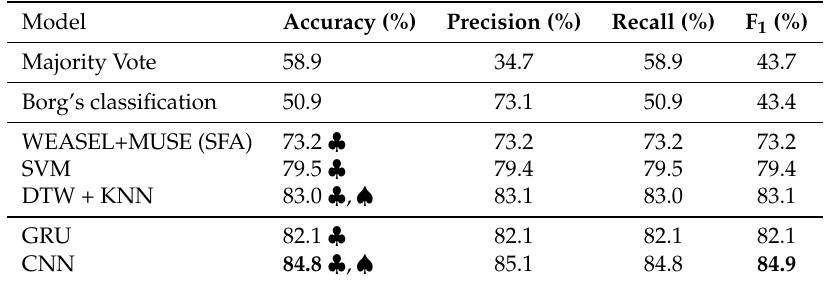
Table 2. Summary of the achieved classification results. All values were obtained using the weighted (by support) averaging scheme. ♣ marks significant difference to the majority vote. ♠ marks significant difference to SFA. The best results are printed in bold.